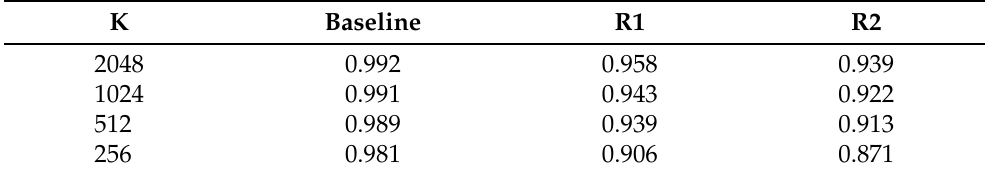
Table 4. This table summarizes the bibliography evaluation performed by calculating the average distance between random papers (Baseline) papers of relevance 2 (R2) or 1 (R1) to the same topic. K Baseline